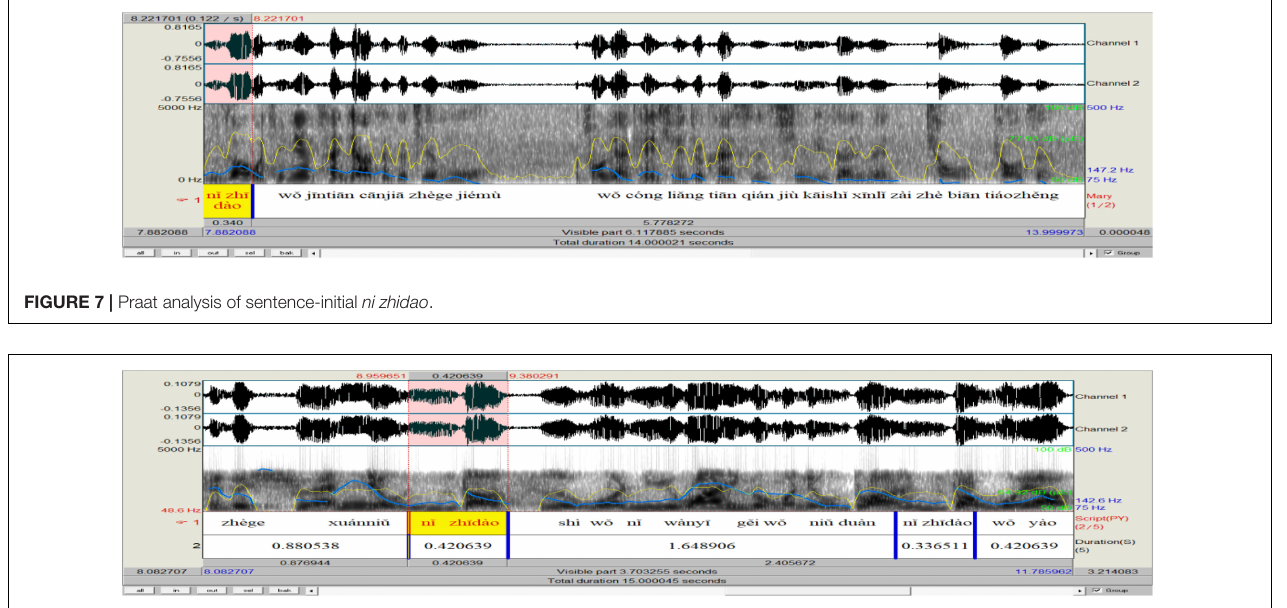
FIGURE 8 | Praat analysis of within-clause ni